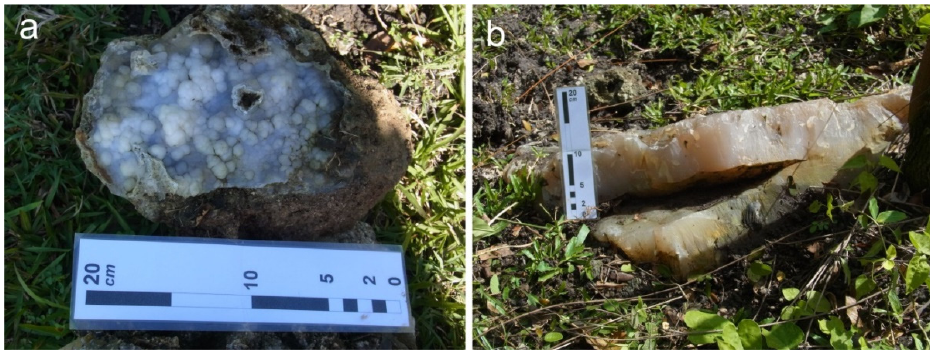
Figure 3. ( a ) Chalcedony with botryoidal texture and ( b ) large yellow agate in weathered volcanic bedrock from El Picado, Cuba.